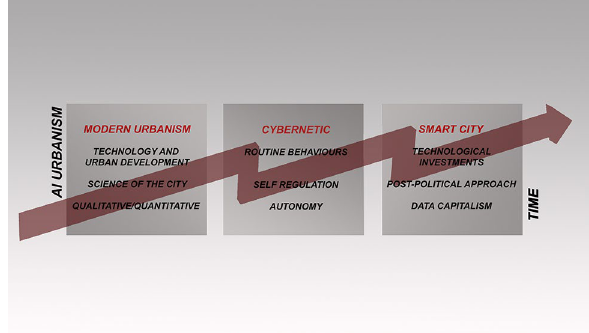
Fig. 1 Temporal coordinate: Modern Urbanism, Cybernet- ics and Smart City as sources of AI Urbanism.